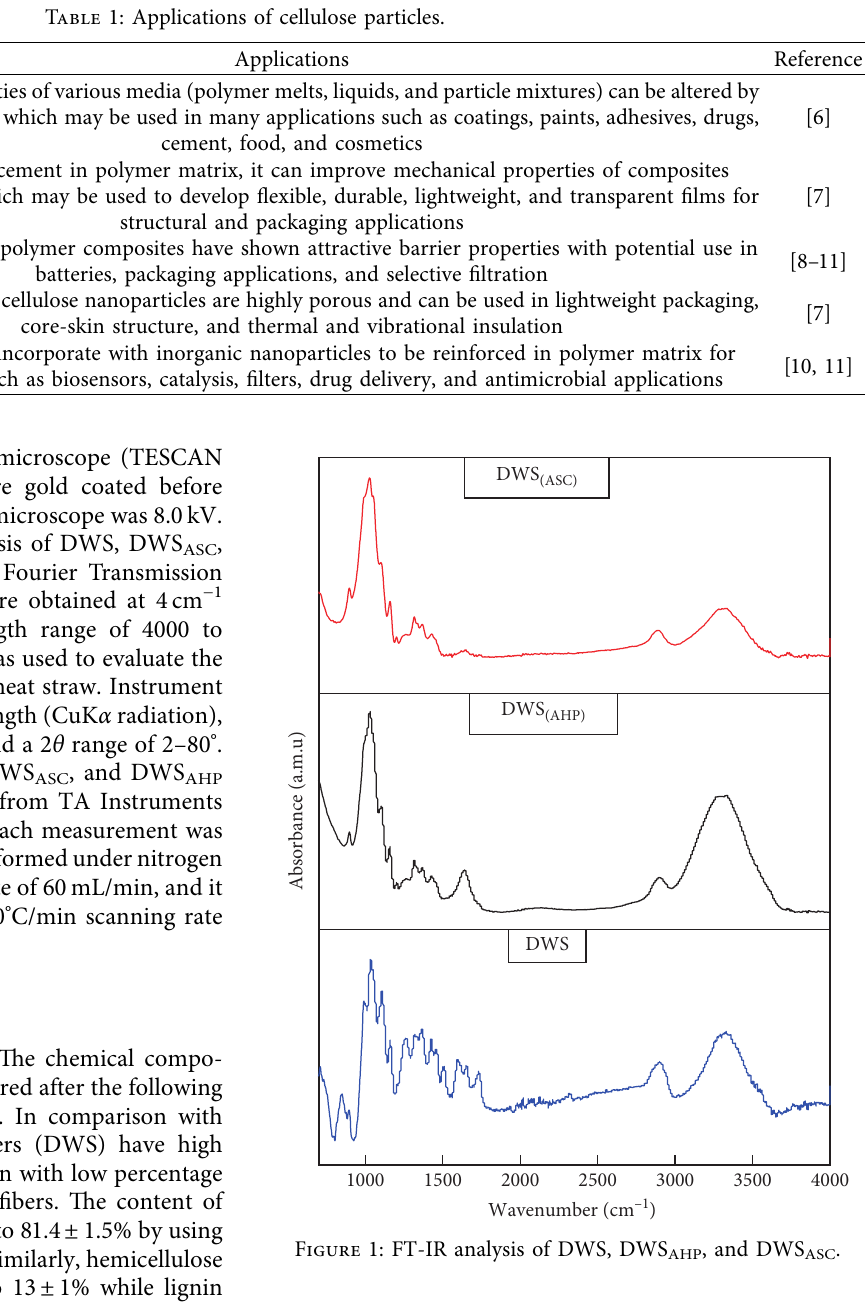
AHP , and DWS ASC .